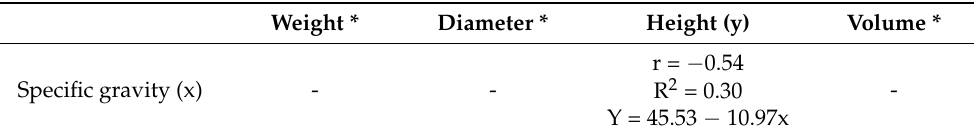
Table 3. Correlation between the geometric parameters of baked muffins and the specific gravity of raw cakes. Weight * Diameter * Height (y) Volume * r = − 0.54 -